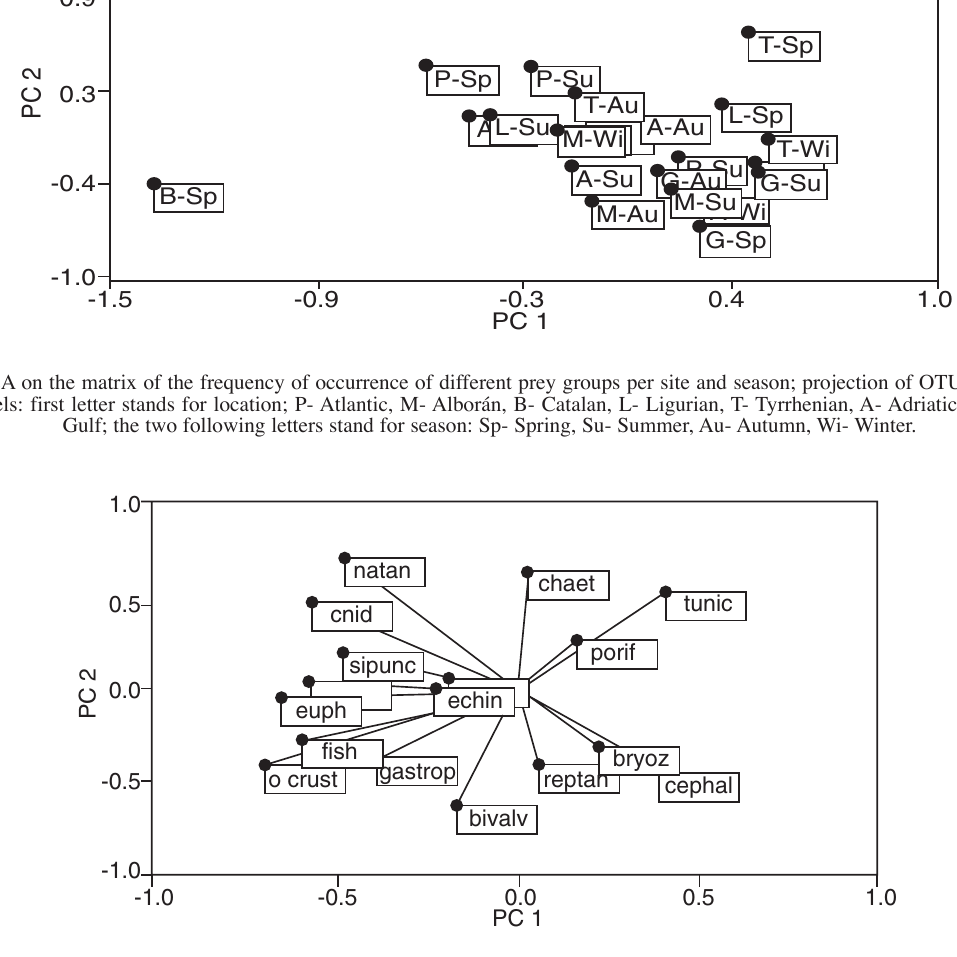
F IG . 3. – PCA on the matrix of different prey groups per site and season; projection of variables over axis 1 and 2. Labels: Porifera - PORIF; Cnidaria - CNID; Scaphopoda - SCAPH; Gastropoda - GASTROP; Bivalvia - BIVALV; Cephalopoda - CEPHAL; Polichaeta - POLIC; Euphausiacea - EUFH; Non Decapod Crustaceans- O.-CRUST; Natantia - NATAN; Reptantia - REPTAN; Sipunculida - SIPUNC; Bryozoa - BRYOZ; Echinodermata - ECHIN; Chaetognatha - CHAET; Tunicata - TUNIC; FISH